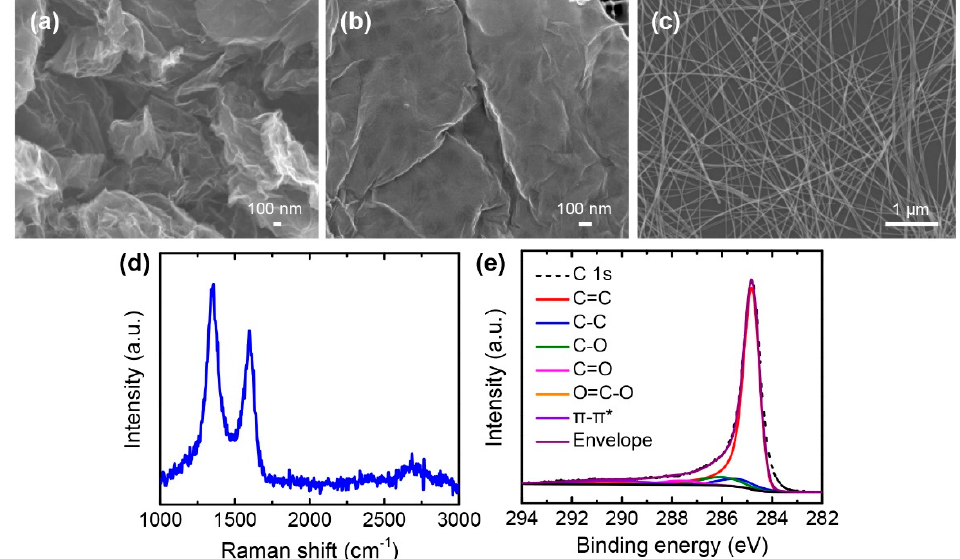
Figure 1. Characterization of reduced graphene oxide (rGO) and silver nanowires (AgNWs). ( a , b ) Scanning electron microscopy (SEM) images of: ( a ) as-received rGO powders; ( b ) Sonicated rGO powders; ( c ) SEM image of AgNWs placed on a silicon substrate; ( d ) Raman spectrum of as-received rGO powders; ( e ) X-ray photoelectron spectroscopy (XPS) C 1s core-level spectra of as-received rGO powders.